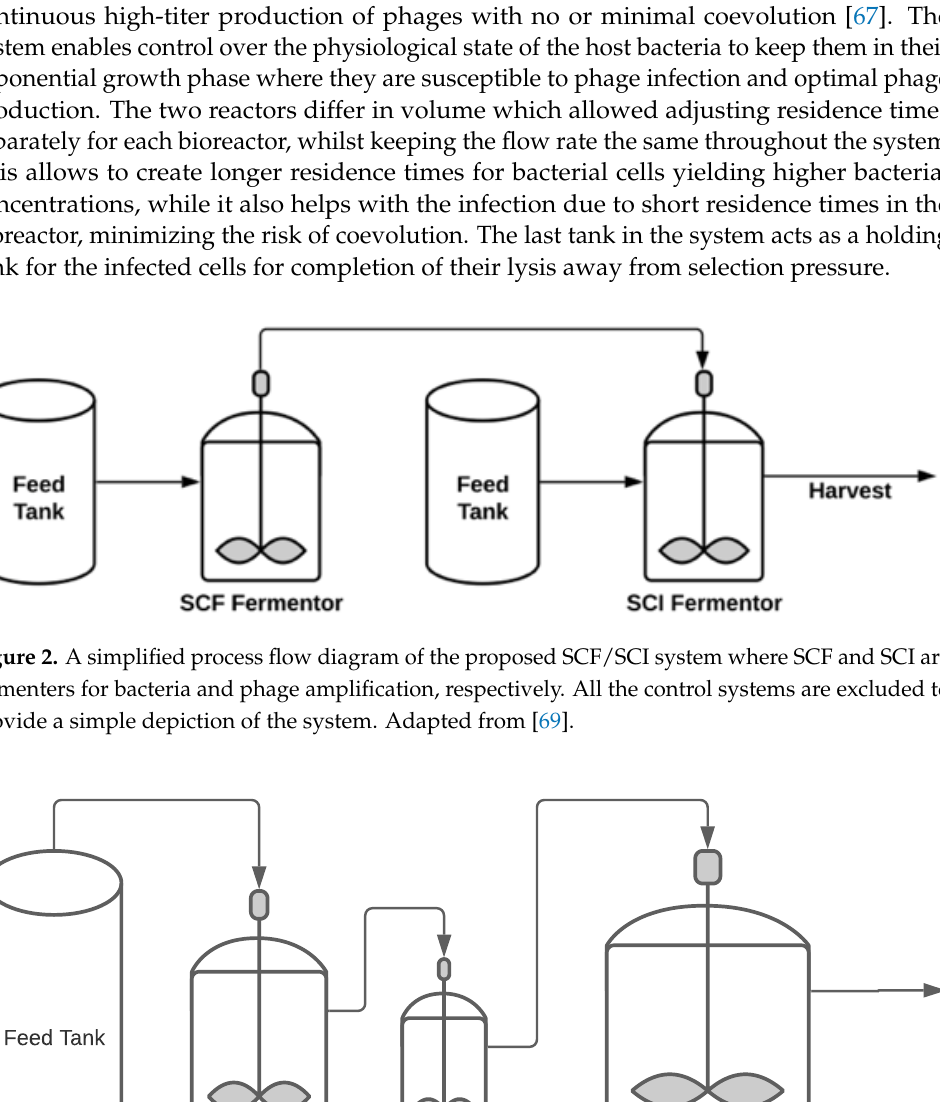
8 of 16 Figure 2. A simplified process flow diagram of the proposed SCF/SCI system where SCF and SCI are fermenters for bacteria and phage amplification, respectively. All the control systems are ex- cluded to provide a simple depiction of the system. Adapted from [69]. Continuous Process